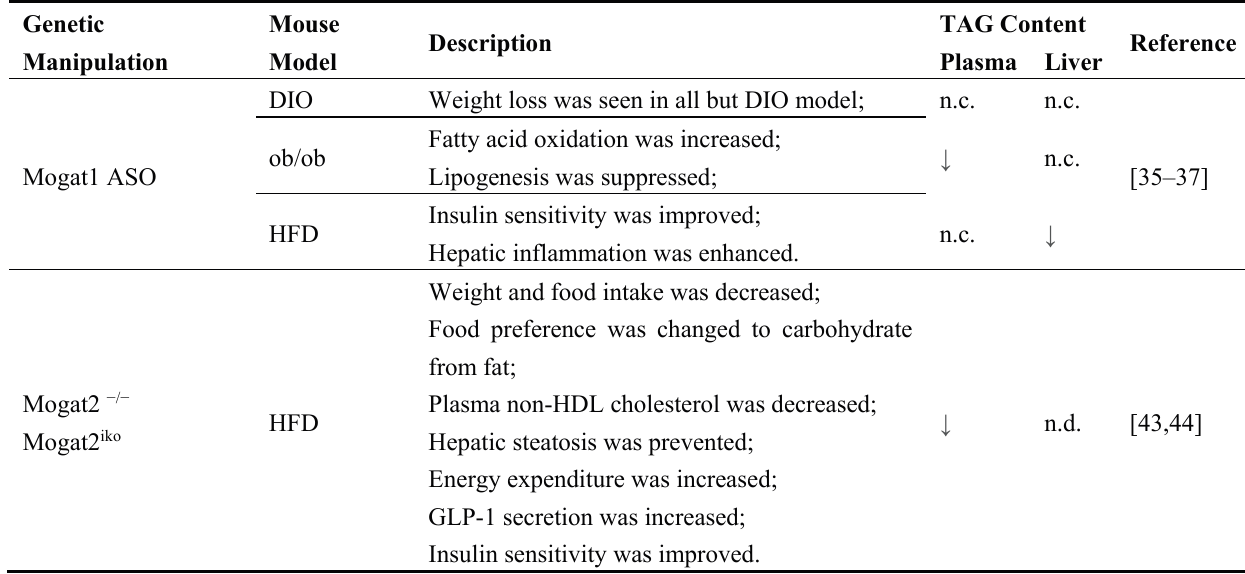
Table 1. Genetic Manipulation of MGAT1 and MGAT2 in Mouse